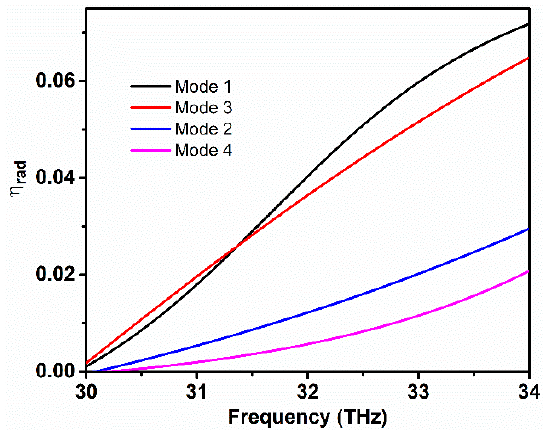
Figure 12. The real and imaginary input admittance at four different characteristic modes.